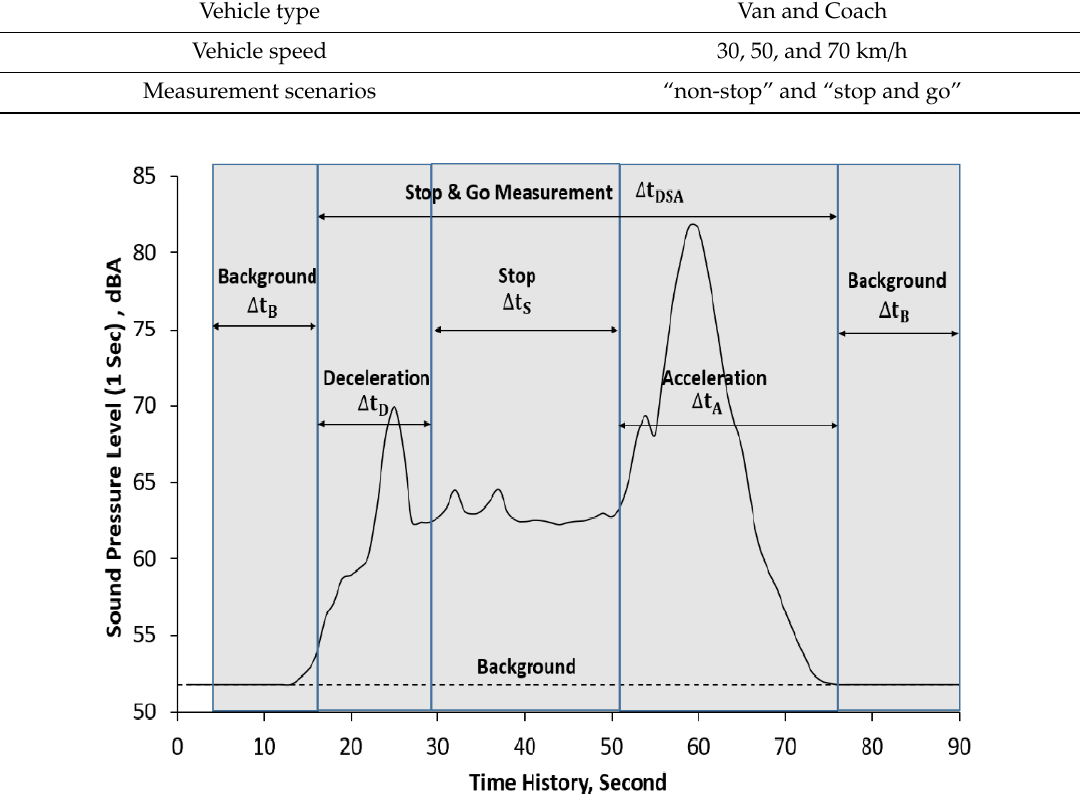
Figure 4. Noise level variation of “stop and go” situation of a single vehicle.